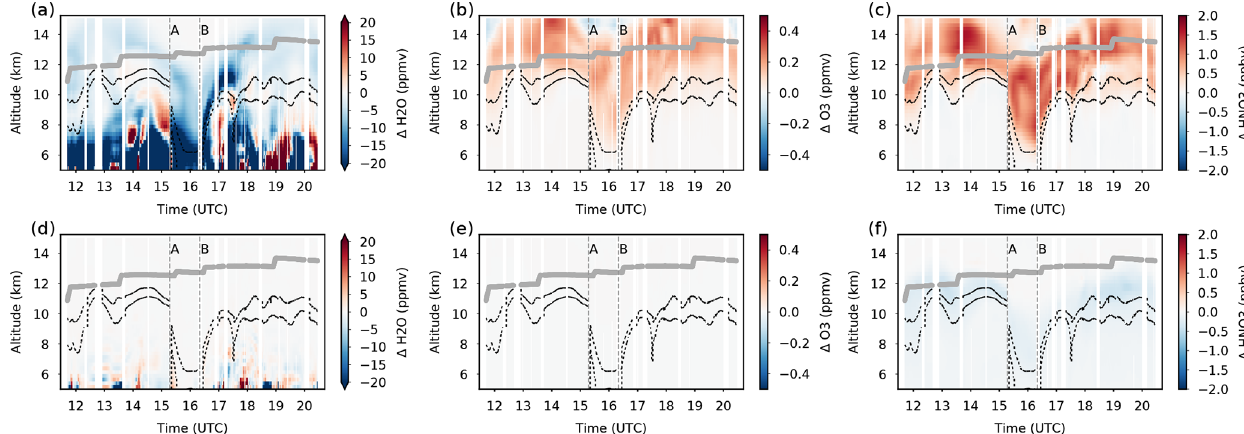
Figure 13. Modelled differences in H 2 O, O 3 and HNO 3 due to lower resolution ( a–c ; T106 − T42 resolution) and neglecting scavenging processes in clouds ( d–f ; EMAC-STD − EMAC-NOSCAV). Dashed black lines: EMAC 2 and 4PVU isolines (lower and higher lines, respectively) as indicators for the dynamical tropopause. Grey lines: HALO flight